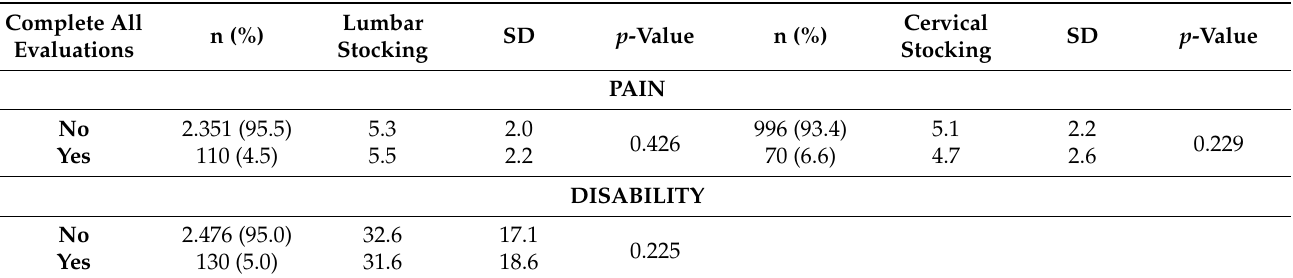
Table 7. Pain and disability as a function of